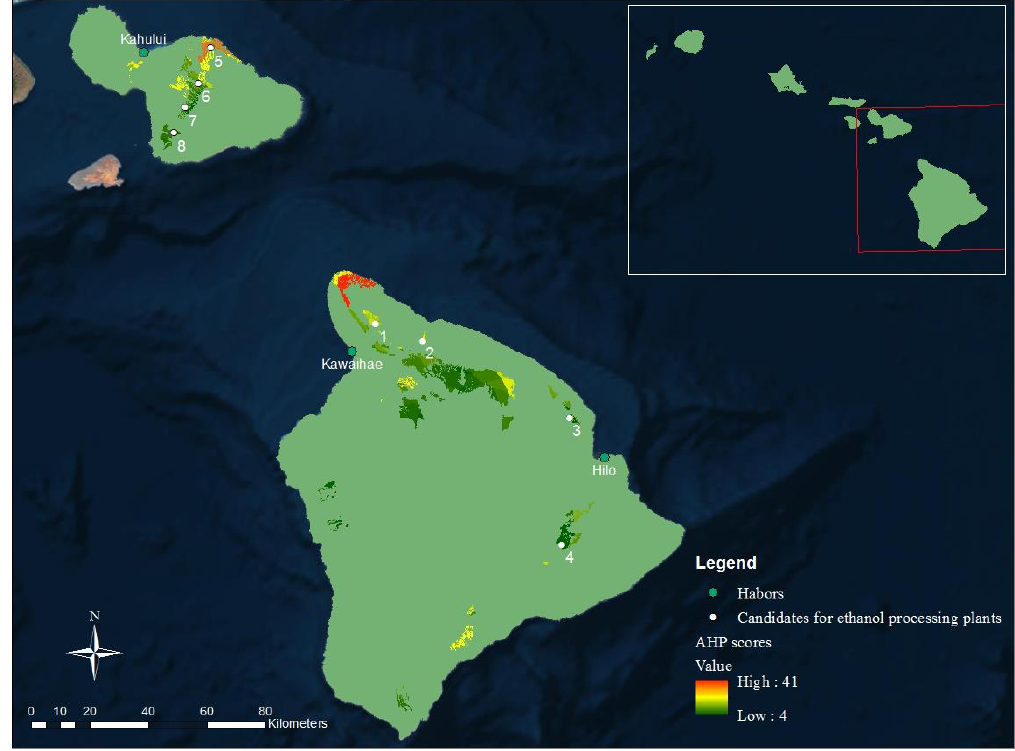
Figure 4. Suitable land areas used for banagrass production.